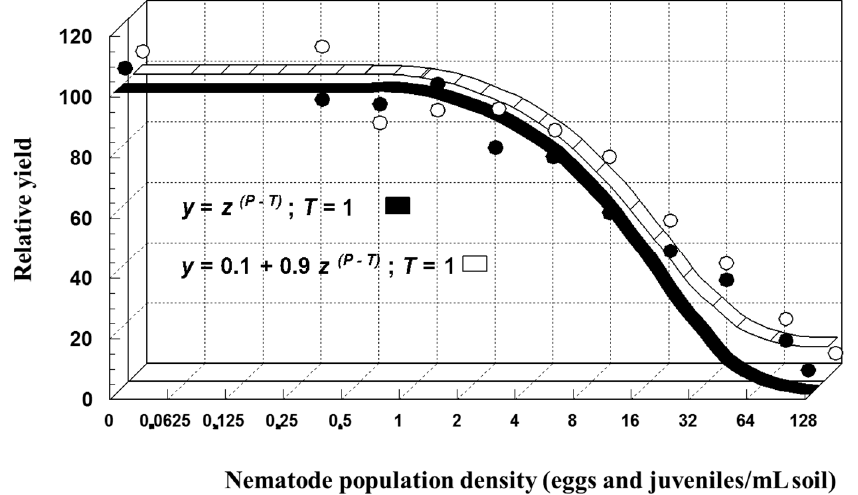
Figure 1. Relationship between plant growth [plant weight (black) and height (white)] and nematode population density in the soil represented by Seinhort’s equation. In this equation, y (relative yield) is the ratio of the yield at a given population density Pi to the yield in the absence of nematodes, m is the minimum relative yield ( y at very large Pi ), z is a constant < 1, where z -T = 1.05; Pi is the nematode population density at transplant or sowing and T is the tolerance limit of the crop to the nematode ( Pi at which no yield is lost).